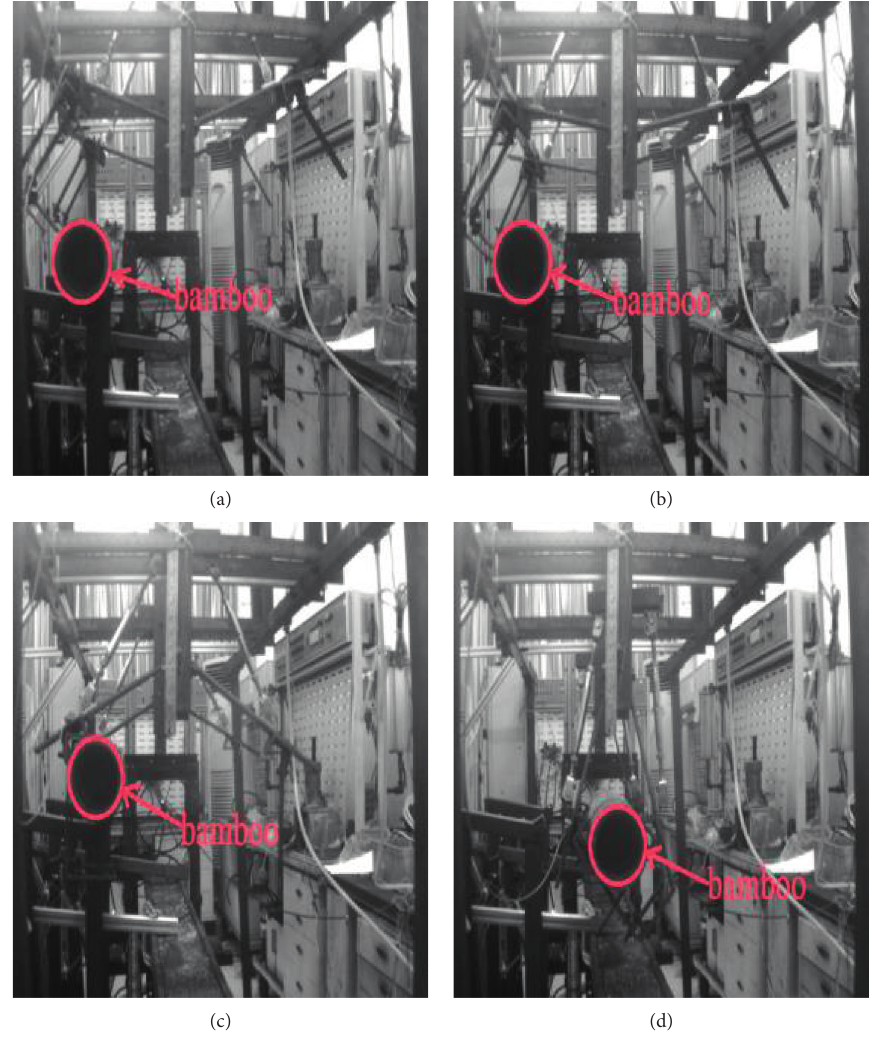
Figure 11: Four captured images in the grasping process.